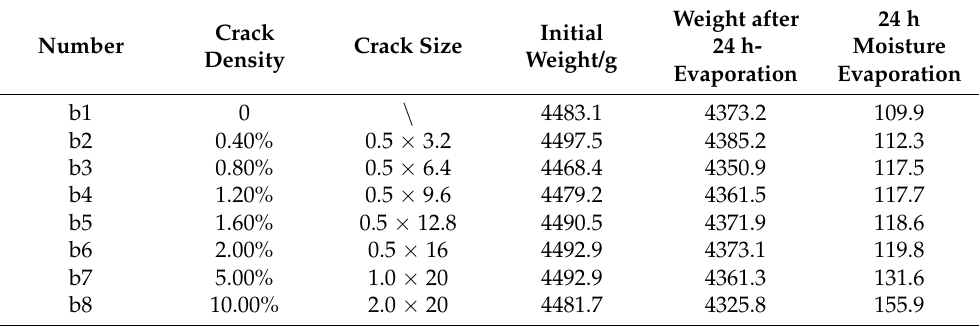
Figure 6. The crack extraction results of the UAV image: ( a ) original image, and ( b ) crack extraction results. The red frame is the coal mining face. Table 3. The experimental results for moisture evaporation for loess soil under different crack densities in 24